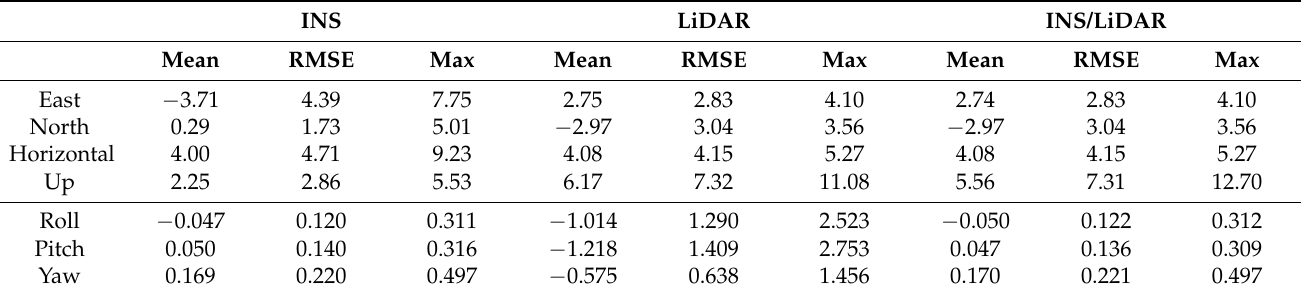
Table A2. D-19—position (m) and attitude (deg) error statistics.